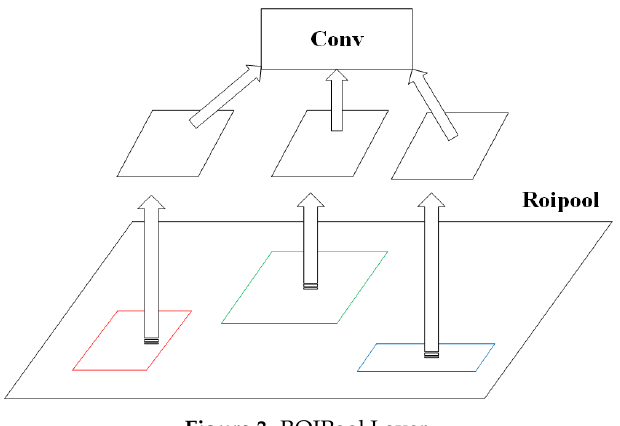
Figure 3. ROIPool